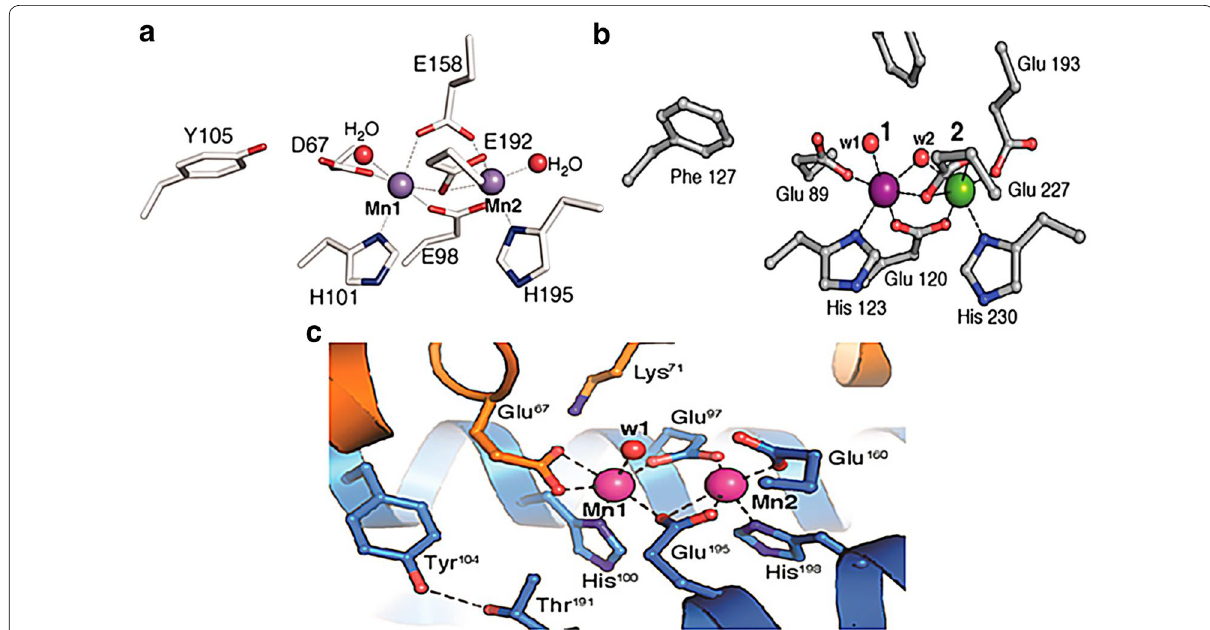
Fig. 3 Ribonucleotide reductase class Ib, Ic and may be Id. a X-ray crystallographic structure of Mn II 2 -NrdF cofactor. Adapted with permission